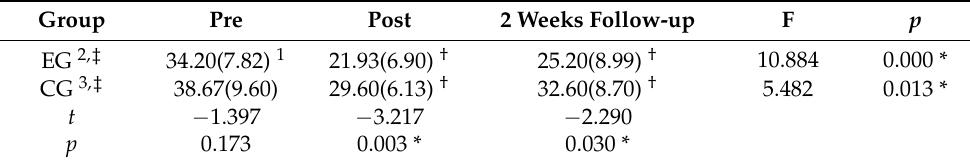
Table 2. Changes in Unified Parkinson’s Disease Rating Scale (UPDRS) by the period.